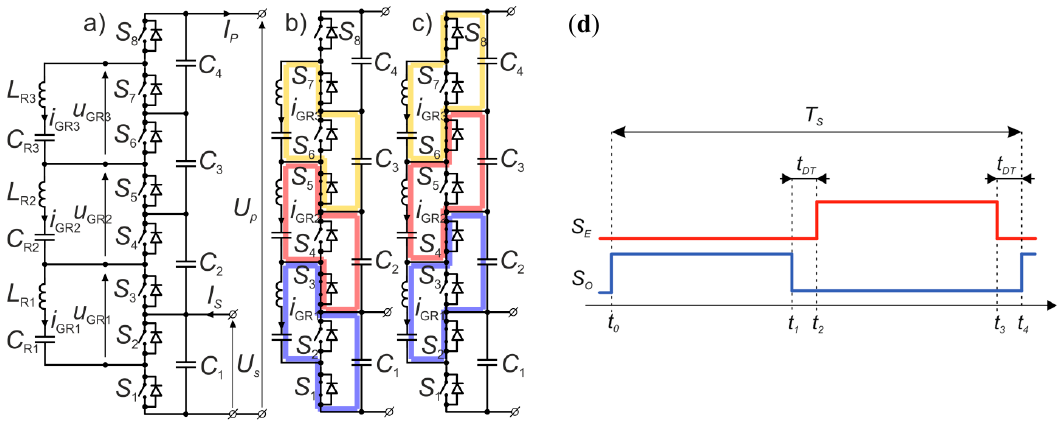
Figure 1. The bidirectional four-level switched capacitor resonant DC-DC converter ( a ) the concept, ( b , c ) the modes of operation, ( d ) the control signals of the switches; S E —control signal of the even switches; S O —control signal of the even switches.